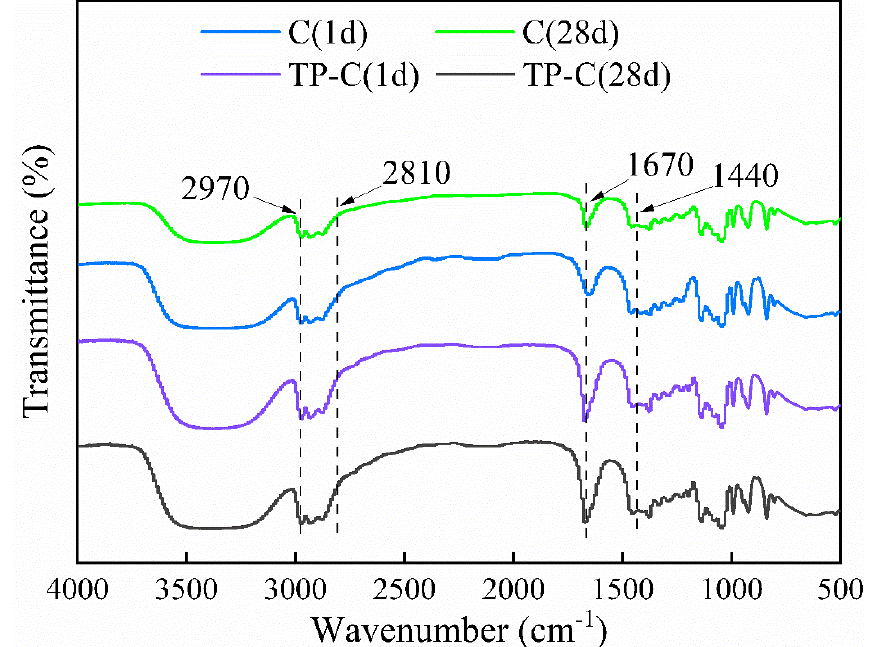
Figure 7. FT–IR infrared spectra of citral and tea-polyphenol–citral.